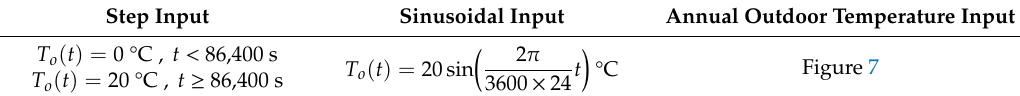
Table 6. Inputs for validation of the system identification.